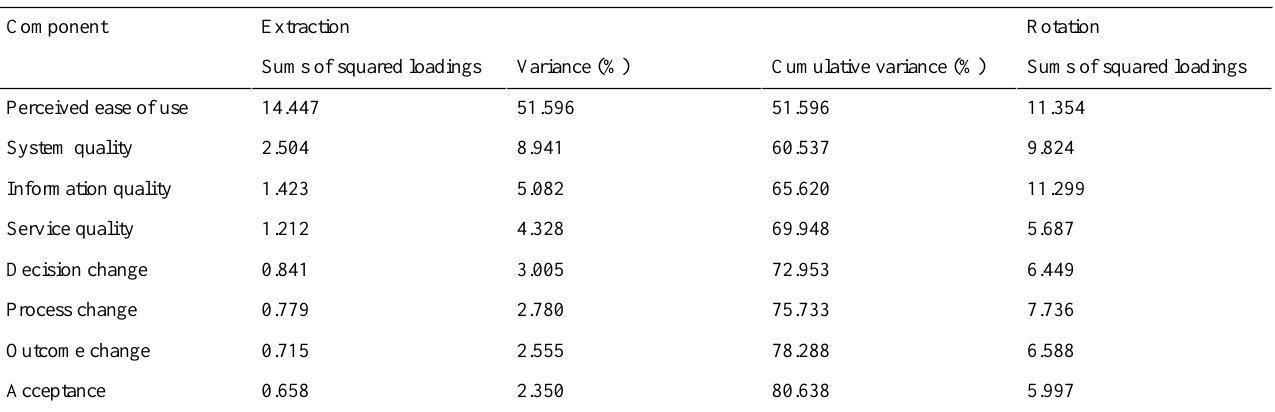
Table 2. Principal component analysis results.